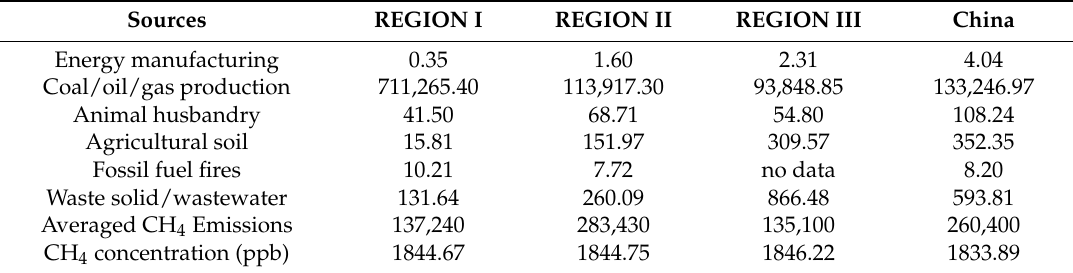
Table 1. The average emissions from different Emissions Database for Global Atmospheric Research (EDGAR) anthropogenic sectors * in three specific geographic regions across China (tons/year).